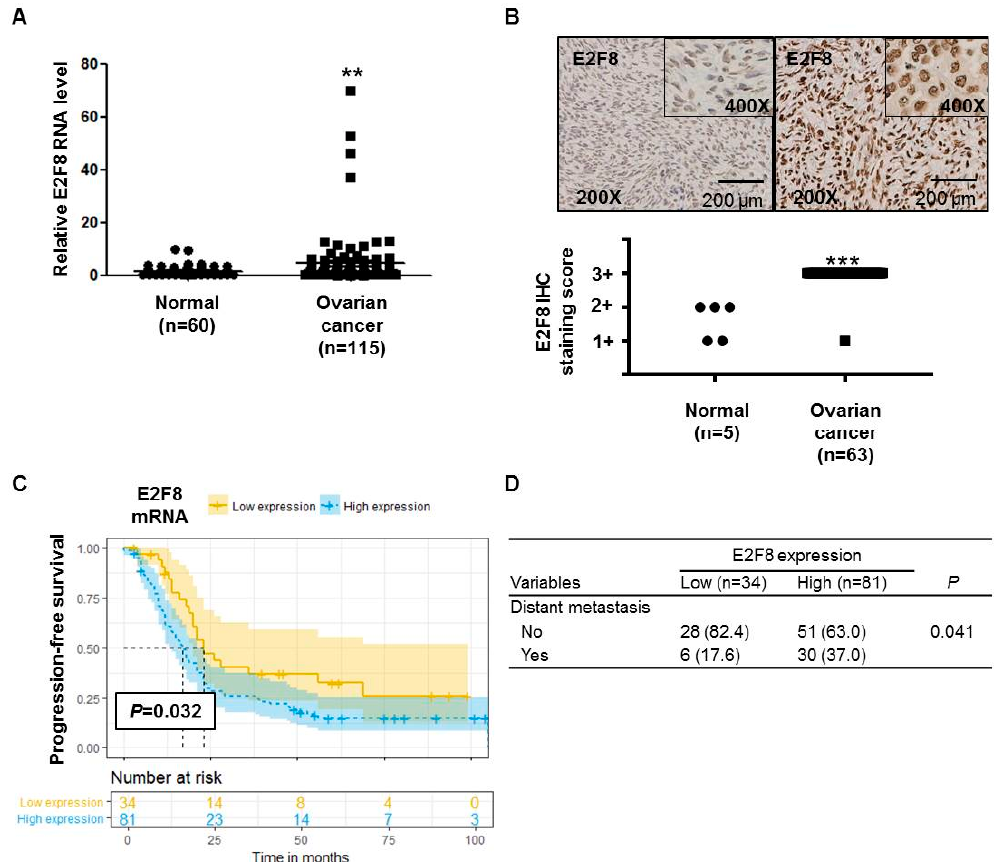
Figure 1. E2F8 expression in ovarian cancer and noncancer tissues and the correlation with prognosis. ( A ) E2F8 expression in ovarian cancer tissues ( n = 115) and noncancerous tissues ( n = 60). ( B ) Representative tissue microarray-based immunohistochemical analysis of E2F8 expression in normal and ovarian cancer tissues. Immunohistochemical analysis of E2F8 protein expression showing a significant difference in E2F8 protein expression between 63 ovarian cancer tissue samples and 5 normal ovarian tissue samples. ( C ) Progression-free survival in ovarian cancer patients with high and low E2F8 expression. ( D ) Comparison of the patient number shown to have distant metastasis according to E2F8 expression. ** p < 0.01, *** p < 0.001 vs. nontumor control.